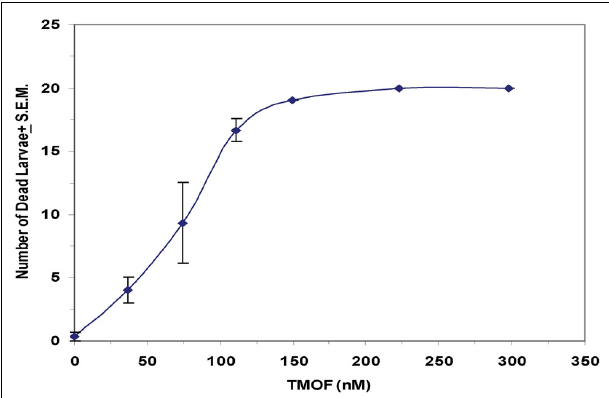
FIGURE 9 | Feeding KM71H- tmf A cells with increasing concentrations of TMOF (0–229 nM) to Ae. aegypti first instar larvae after high volume (150 L) fermentation and heat treatment in an oven (entry at 210 ◦ C and exit at 85 ◦ C). Heat treated cells were fed for 12 days and mortality was daily determined. Groups of 5 larvae were tested in 25 ml sterile tissue culture wells. The amount of TMOF in heat treated cells was determined by ELISA. Results are expressed as means ± SEM.